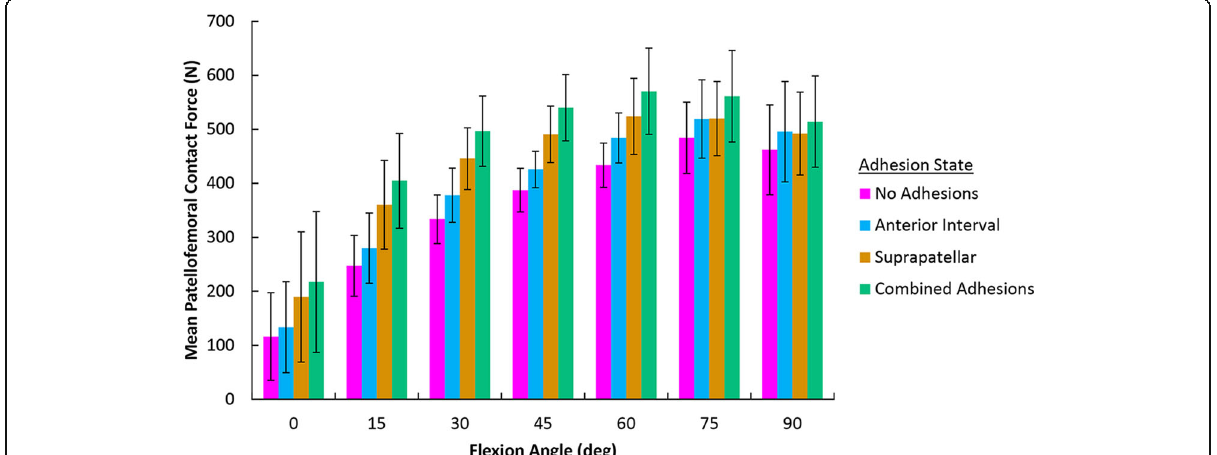
Fig. 3 Patellofemoral contact force at each adhesion state (and across all flexion angles) was significantly different from the other adhesion states ( P ≤ 0.007). Combined anterior interval adhesions resulted in the highest contact force followed by isolated suprapatellar adhesions, isolated anterior interval adhesions, and the no adhesions state